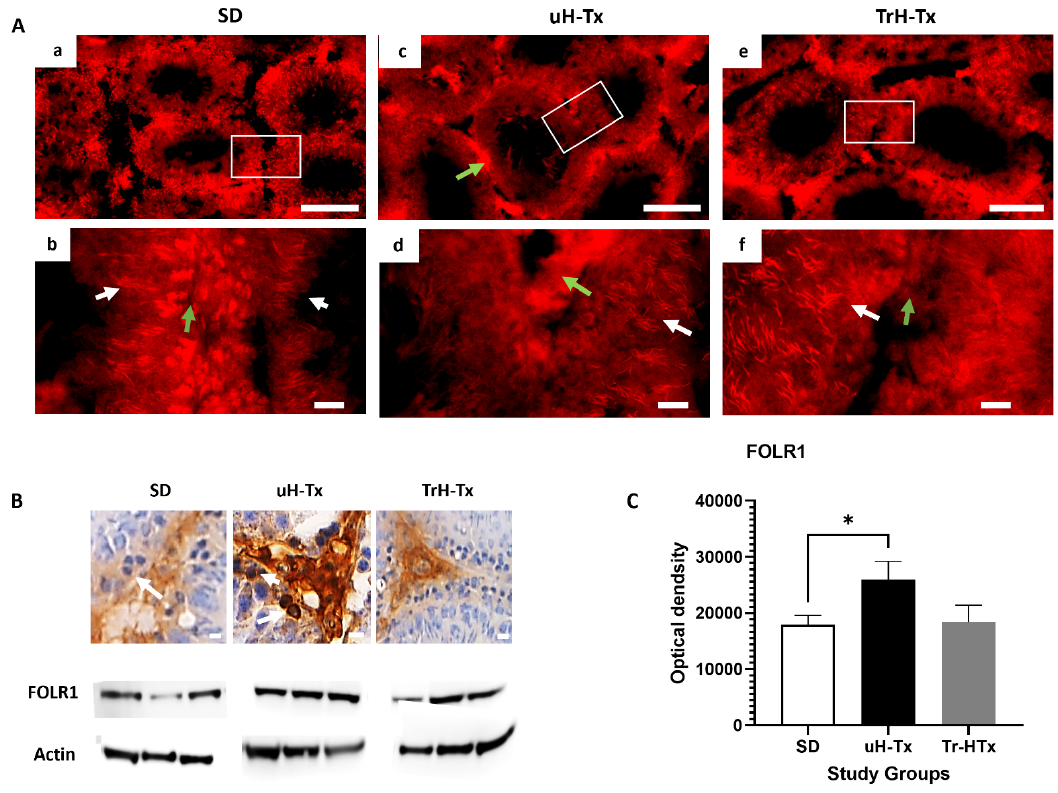
Figure 3. Folate receptor alpha (FR α or FOLR1) expression. ( A ) Immunofluorescent staining for FOLR1 in SD ( a , b ), uH-Tx ( c , d ), and TrH-Tx ( e , f ) (( a , c , e ) at 100×, scale: 200 µm and ( b , d , f ) at 400×, scale: 25 µm). White boxes in ( a , c , e ) are regions enlarged in ( b , d , f ). Green arrow points to areas outside tubules, including smooth muscle, that are FOLR1 positive in uH-Tx but not in SD or TrH-Tx, with little if any positive staining within uH-Tx tubules except for mature sperm (white arrows) ( B ) Immunoperoxidase staining of FOLR1 more clearly demonstrates the difference in subcellular localisation. White arrows indicate nuclear FOLR1 expression in uH-Tx testes and a lack of nuclear expression in SD and TrH-Tx rats (400×, scale: 25 µm). Western blot analysis of tissue lysates ( B ) shows an increased FOLR1 protein expression in uH-Tx with restoration to SD control levels in TrH-Tx rats ( C ). Densitometric analysis shows statistically significant increased FOLR1 in uH-Tx testes compared to SD (*: p ≥ 0.05). The results are representative of n = 4–6 rats with a minimum of three sections from different locations of testes and three repeated blots. FRα (also called folate receptor 1, FOLR1) was observed in Leydig cells and spermat- ogonia, with less abundance in secondary spermatozoa, and round cells. Elongated and